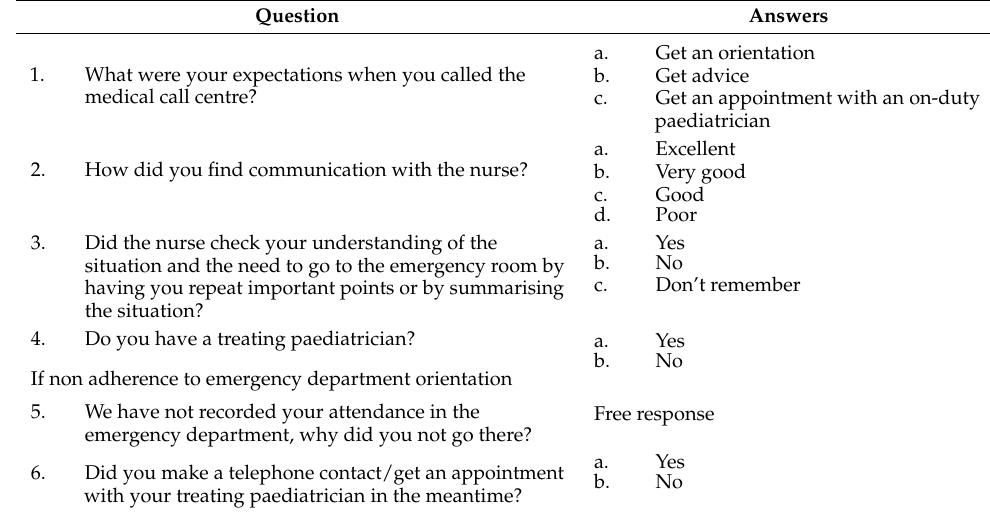
Table 1. Telephone